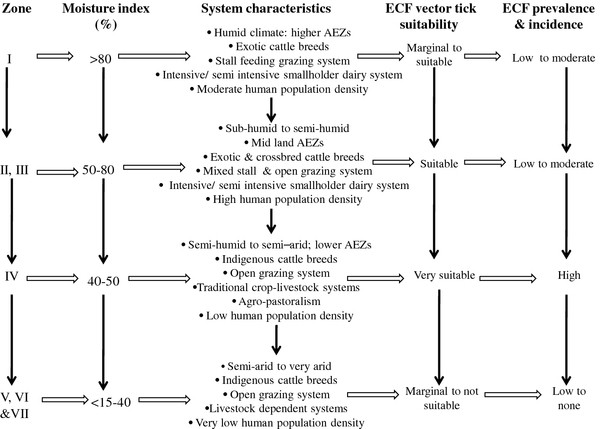
Illustration of gradient of effects of AEZs, farming systems, ECF vector suitability characteristics and corresponding ECF qualitative prevalence and incidence levels in Kenya.